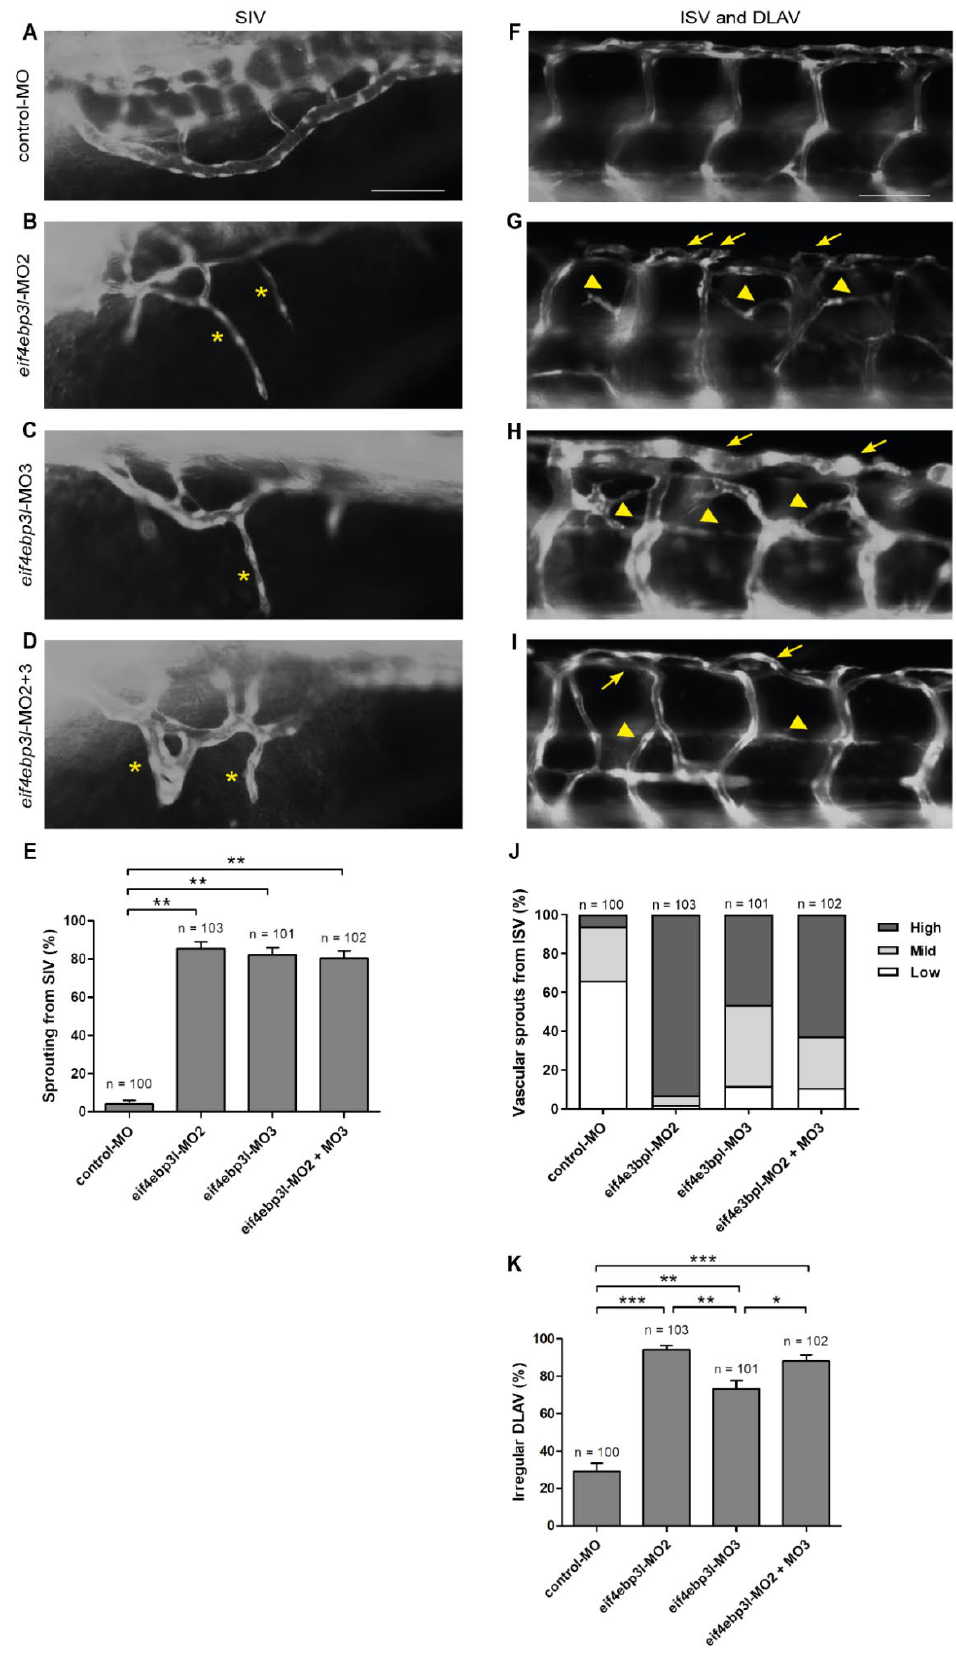
Figure 1. Loss of eukaryotic initiation factor 4E binding protein 3 like ( eif4ebp3l) induced sprouting angiogenesis during zebrafish vascular development. ( A – I ) Lateral view of morpholino-injected